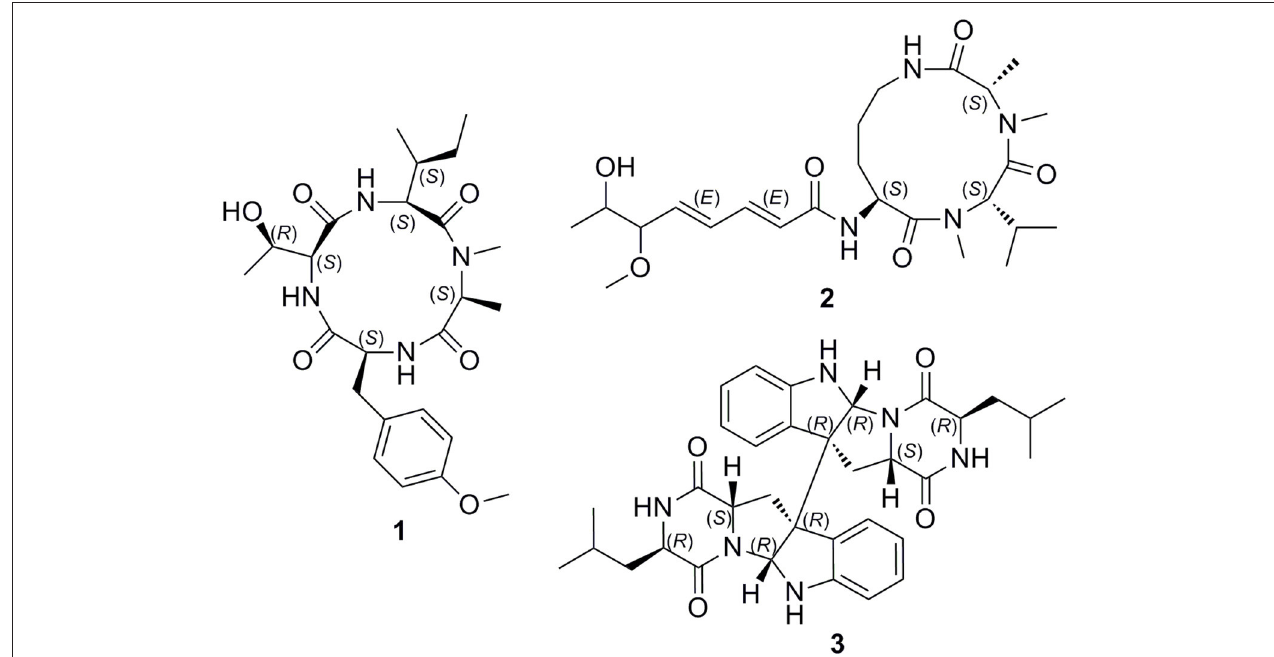
FIGURE 1 | Structures of compounds 1-3